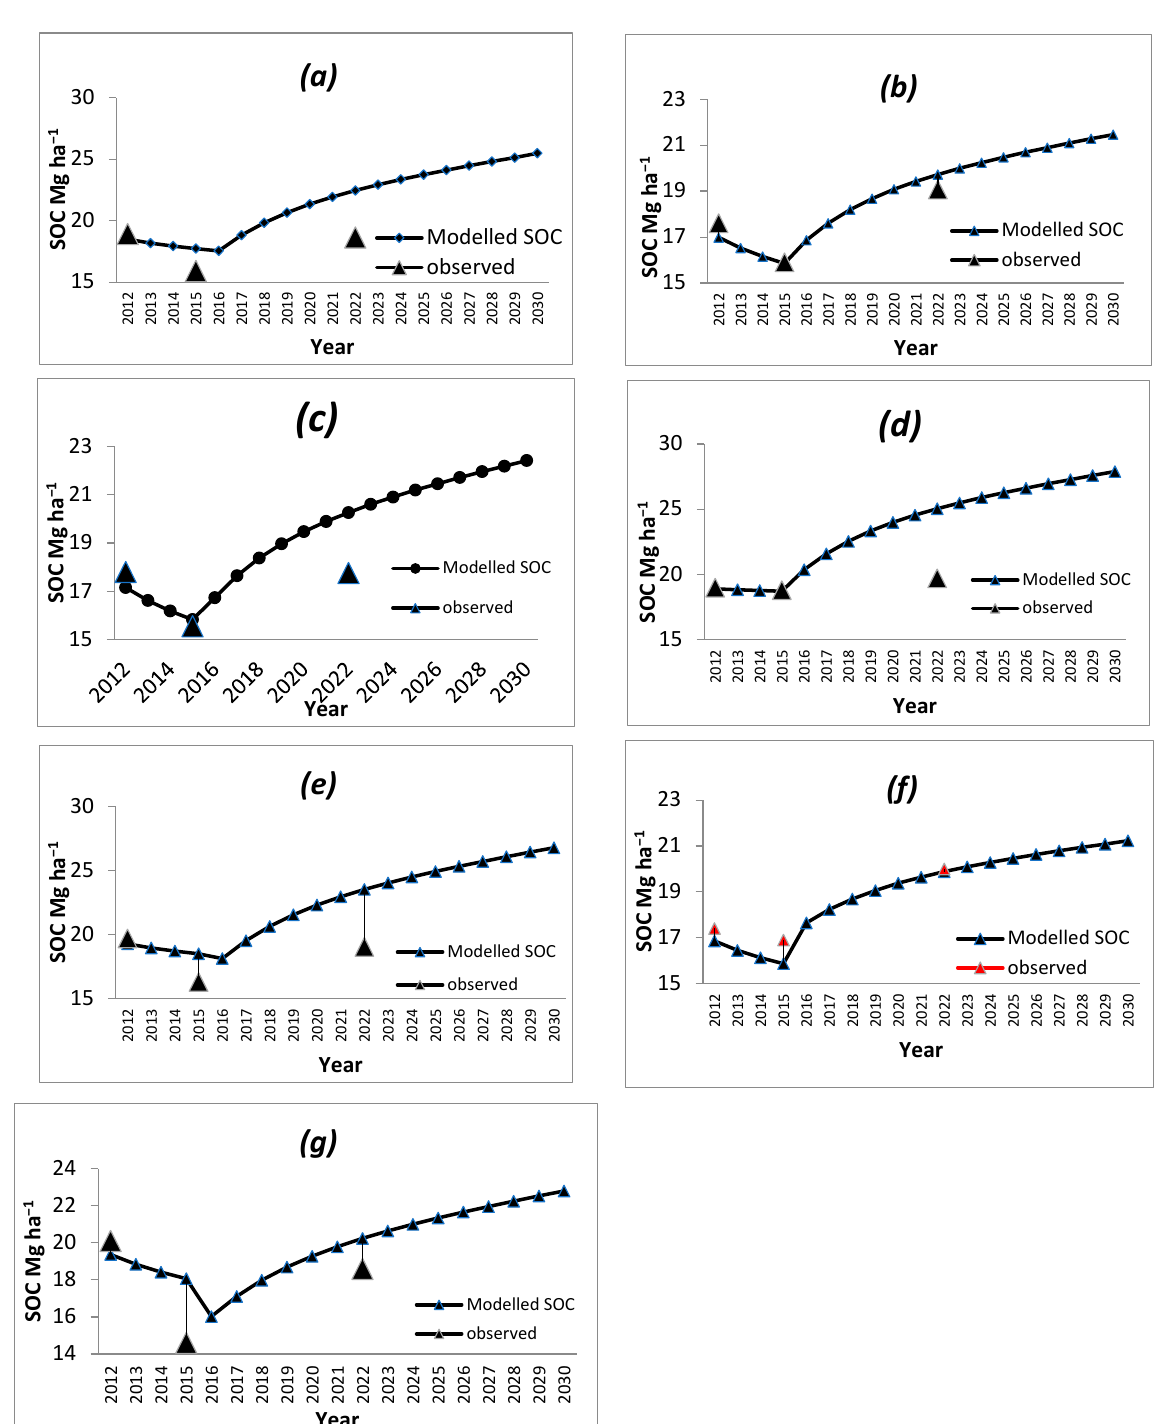
Figure 2. Observed and modeled SOC under a usual scenario in ( a ) B. balcooa , ( b ) B. bambos , ( c ) B. nutans , ( d ) B. vulgaris , ( e ) D. hamiltonii , ( f ) D. stocksi and ( g ) D. strictus.